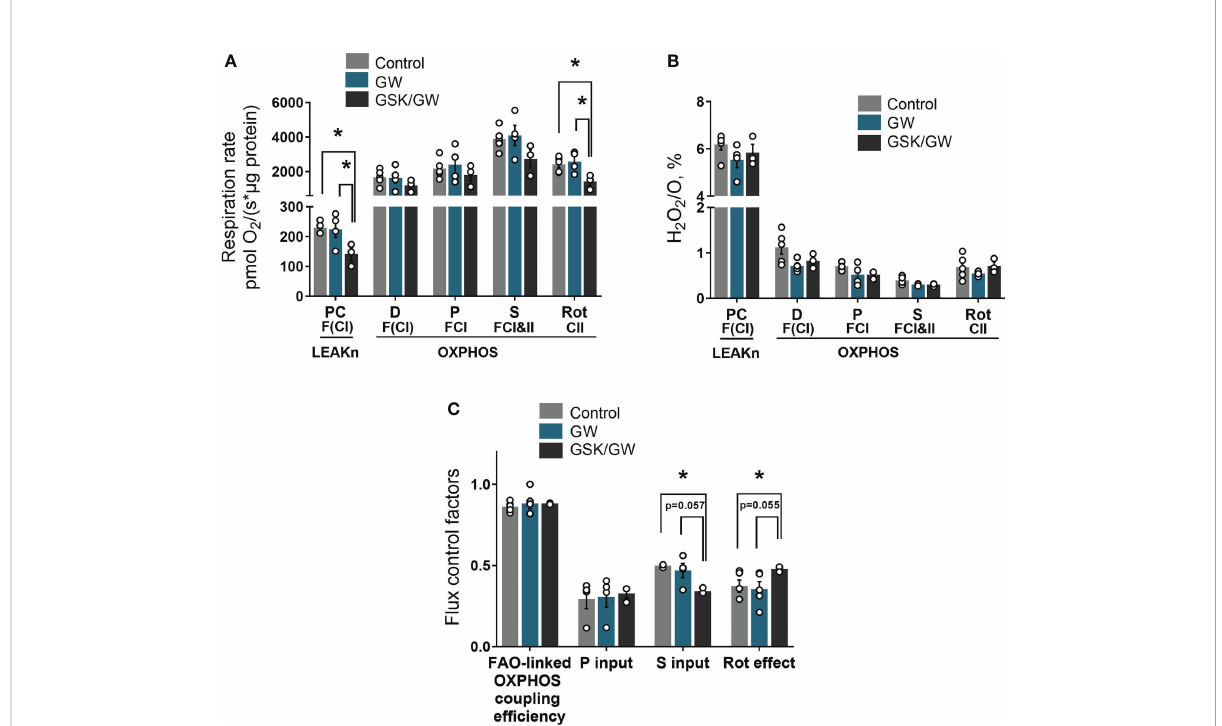
FIGURE 2 PPAR b / d inhibition modulates basal mitochondrial respiration rate. (A) Respiration rate in intact cardiac mitochondria (B) H 2 O 2 % ratio between O 2 fl ow and H 2 O 2 production rate, per m g of protein in the presence of PC (palmitoyl-carnitine), D (ADP), P (pyruvate), S (succinate) and Rot (rotenone – complex I inhibitor). The fl uorescence signals were calibrated using H 2 O 2 titrations at the corresponding state (C) Substrate fl ux control factors calculated as: (respiration rate after the addition of substrate - respiration rate before the addition of substrate)/respiration rate after the addition of substrate. PC, palmitoyl-carnitine; D, ADP; P, pyruvate; S, succinate; Rot, rotenone – complex I inhibitor; F(N), fatty acid oxidation-dependent pathway (FADH2 and (NADH)); S, succinate-dependent pathway (FADH2); LEAKn, substrate metabolism-dependent state; OXPHOS, oxidative phosphorylation-dependent state; FAO, fatty acid oxidation; GW, pretreated with PPAR b / d agonist GW0742; GSK/GW, pretreated with PPAR b / d antagonist GSK0660 and then pretreated with PPAR b / d agonist GW0742. Results are presented as means ± SEM of 3-5 independent experiments. *p <